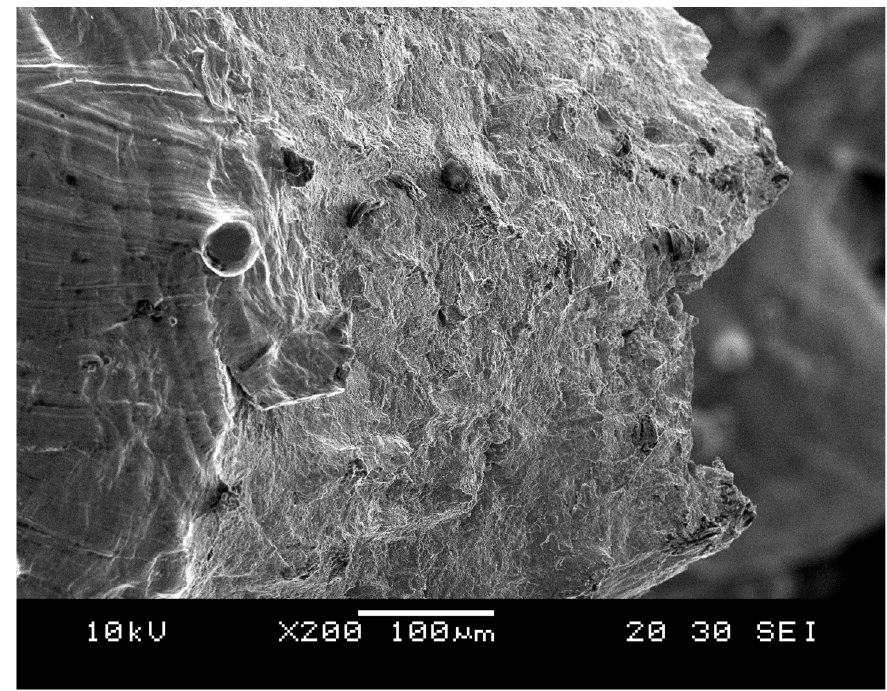
Figure 14. Rough and dull fractures surface for cubic scaffold (SEM).